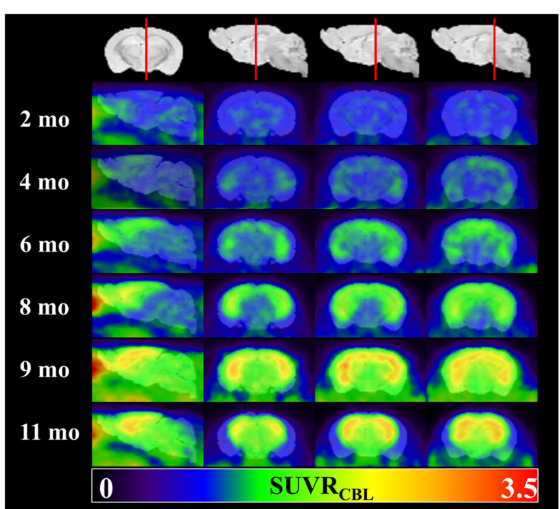
Figure 2. Representative 18 F-PM-PBB3 PET images of di ff erent animal groups.